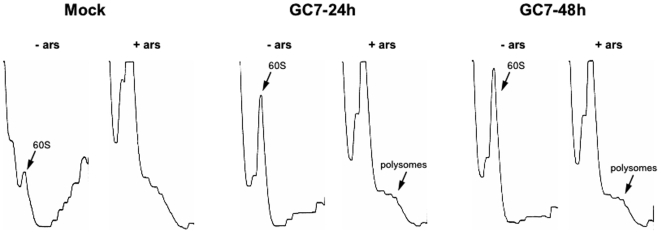
GC7-mediated hypusination inhibition phenocopies eIF5A knockdown.U2OS cells were treated with GC7 (10 µM) or vehicle control (Mock) for the indicated times before culturing cells in the absence (−ars) or presence (+ars) of 0.1 mM sodium arsenite for 1 hour and processing for sucrose gradient analysis. The migration of 60S ribosomal subunits and preserved low density polysomes are indicated.